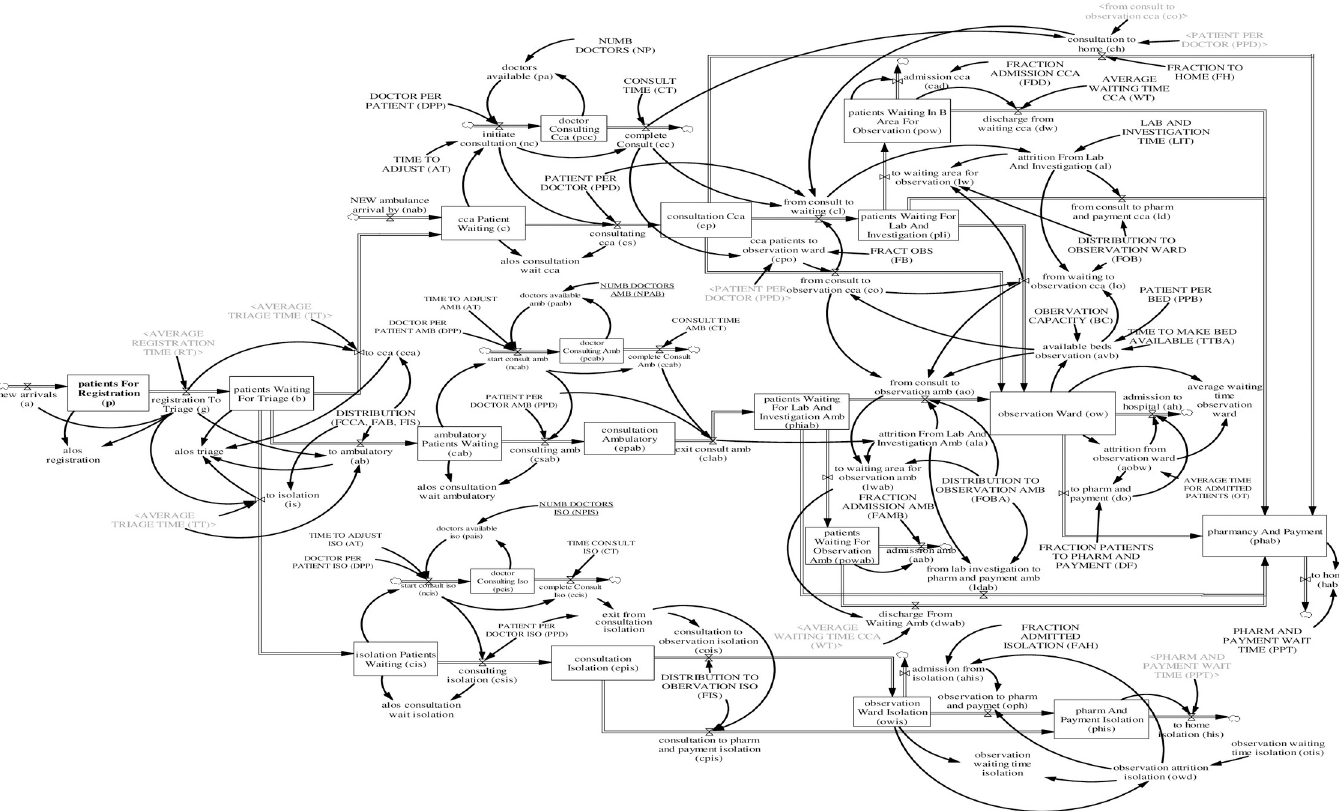
Fig 4. Overall model structure of an ED in